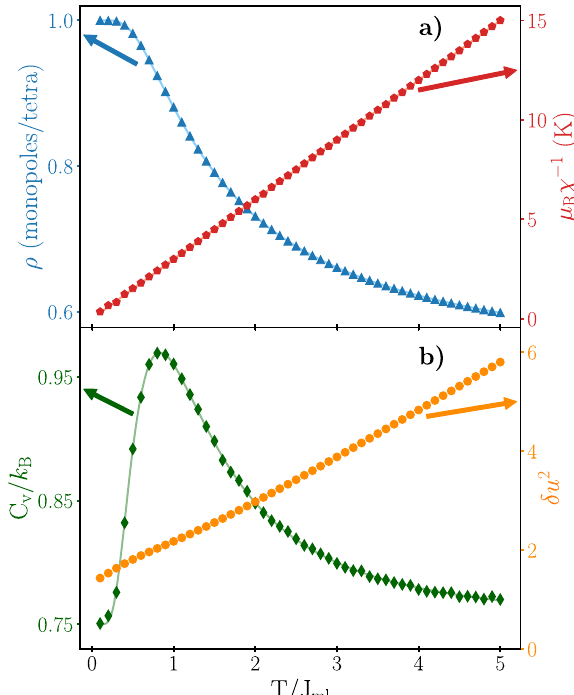
Fig. 2 Monopole liquid. Monte Carlo simulations for the Magnetoelastic Spin Ice (MeSI) model de fi ned by Eq. (2), with coupled elastic and magnetic degrees of freedom (symbols). This model supports a liquid of single magnetic monopoles as a ground state. In order to see this, the exchange constant in the absence of distortions was set to J 0 = 0, the magnetic fi eld to h = 0, and the energy scale associated with the stability of magnetic monopoles to J ml ¼ 3 ~ α 2 = K ¼ 1 K . The cubic lattice we simulated had N = 8192 spins and N /2 moving O − 2 ions. By integrating out the lattice degrees of freedom, this compound system can be transformed into an effective magnetic model (Eq. (5)) studied previously 29 . The analytical results from Barry and Wu 66 for the effective model are also plotted (full lines). a Left axis: density of monopoles ρ as a function of temperature. ρ saturates at 1 single monopole per tetrahedron for T << J ml , while the system retains all the symmetries it had at high temperature. Right axis: inverse of the magnetic susceptibility χ vs. temperature. As noted in ref. 29 , the spin part behaves as a perfect paramagnet; there are no spin correlations at any temperature, with a perfect Curie-law for the inverse susceptibility χ − 1 . b Speci fi c heat per unit spin C V (left) and the mean quadratic deviation δ u 2 (right axis) vs temperature. Both curves make evident that we are dealing with a coupled composite system, with magnetic excitations and lattice distortions. Due to the elastic contribution H el from the oxygen ions, we needed to add a constant term 3/4 to the analytical solution to match the simulations. Also, δ u 2 ( T ) is not just a straight line: the O − 2 equilibrium position depends on the spin con fi guration in δ O